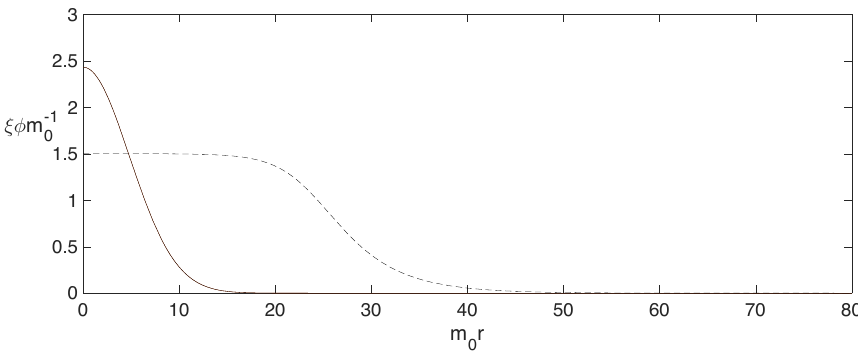
for the Gaussian oscillon example in the text. (cid:1) (cid:28)